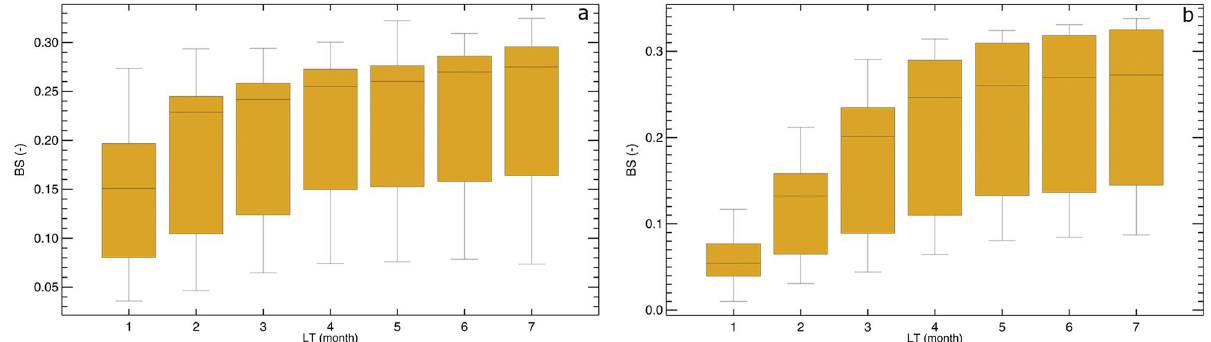
Figure 2. Box and whisker plot showing drought forecast performance denoted by the Brier Score (BS) for major European rivers: ( a ) BS for SSI-1 with LTs from 1- to 7-month and ( b ) BS for SSI-3 with LTs from 1- to 7-month. Lower box shows 25 percentile, middle line shows median, and upper box shows 75 percentile. The whiskers show the 10 and 90 percentiles.